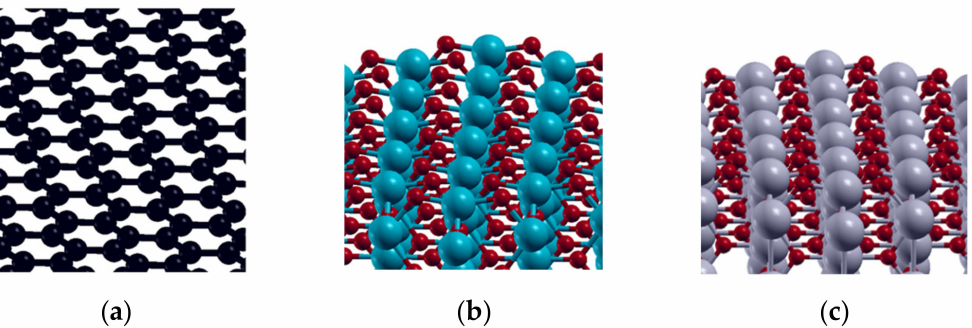
Figure 10. DFT models of investigated surfaces: and: ( a ) graphene (0001); ( b ) SnO 2 -rutile(001) and ( c ) PbO 2